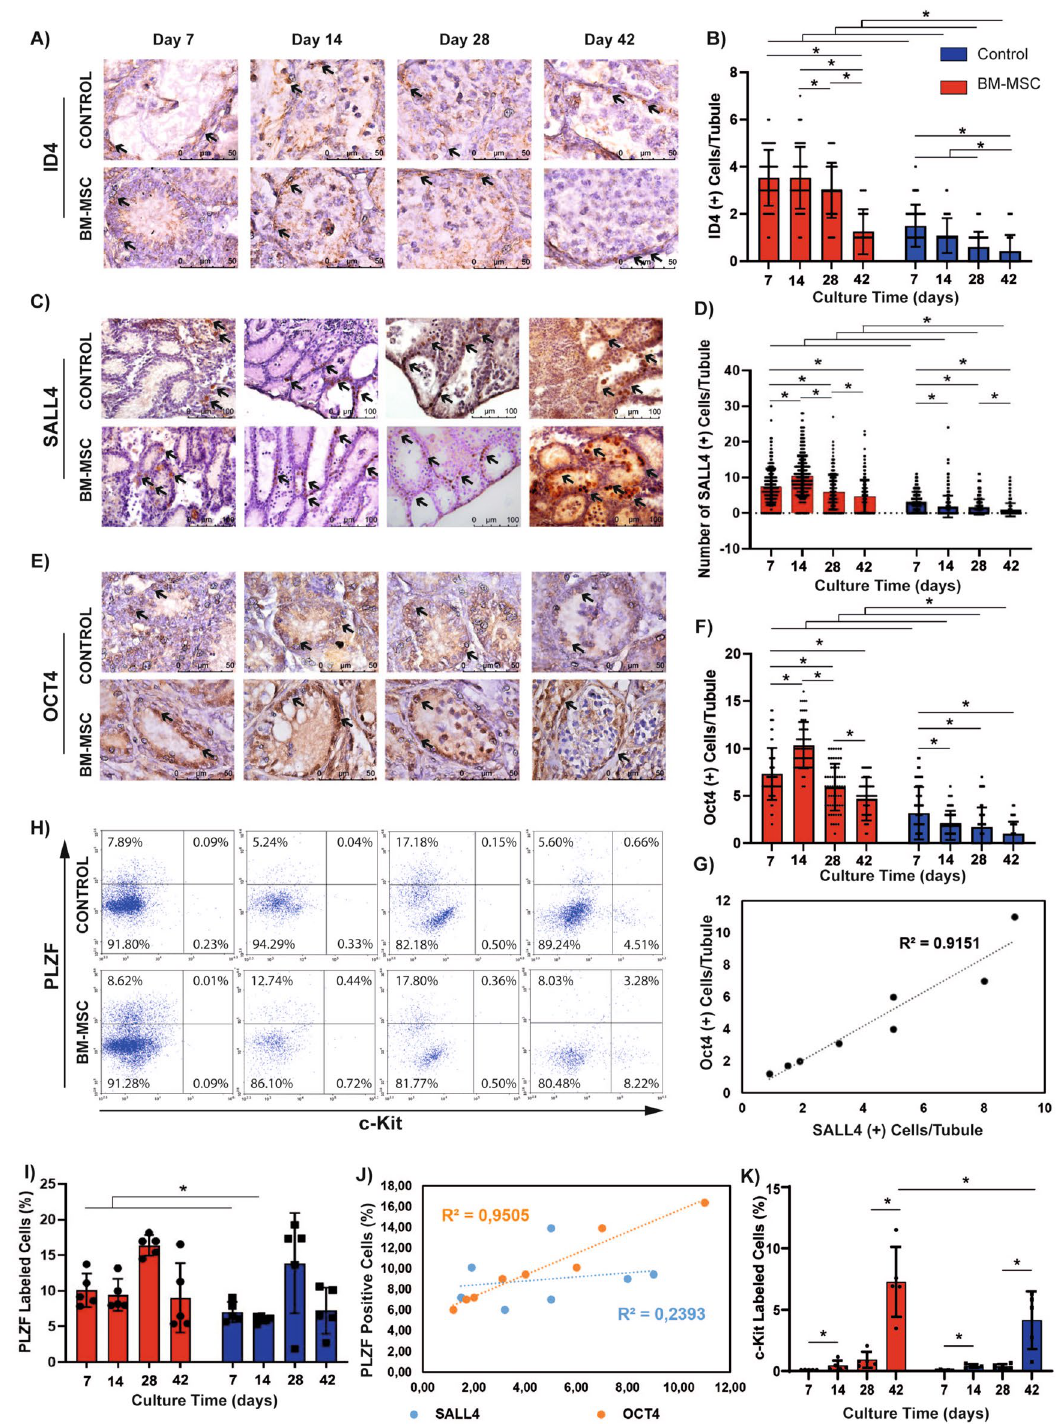
Figure 3. BM-MSCs induce the survival of ID4(+) SSCs, expansion of SALL4(+) and OCT4(+) SSPCs and c-Kit(+) differentiating GCs in vitro. Immune labeling of ( A ) ID4(+) SSCs, ( C ) SALL4 and ( E ) OCT4(+) SSPCs in neonatal mouse testes cultured for 7, 14, 28 and 42 days (ID4 and OCT4: 1000x, SALL4: 400x). The time dependent change in number of ( B ) ID4(+), ( D ) SALL4(+) and ( F ) OCT4(+) cells in BM-MSC co-culture and control group is illustrated in bar graph with standard deviation and data distribution (* p < 0.05, n = 6 testes, 300 tubules for SALL4, 60 tubules for ID4 and OCT4). ( G ) Line graph illustrates the positive correlation between OCT4 and SALL4 labelling for SSPCs in control and BM-MSC groups (R 2 = 0.9151, p < 0.05). ( H ) Flow cytometry of PLZF and c-Kit in cultured testes. ( I ) Average PLZF expression in each group was shown in bar graph with standard deviation and distribution (*p < 0.05, n = 6). ( J ) Line graph illustrates the positive correlation of SALL4 and OCT4 with PLZF for SSPCs in control and BM-MSC groups (R 2 = 0.9505 for OCT4, R 2 = 0.2393 for SALL4, p < 0.05) ( K ) The expression of c-Kit in each group was shown in bar graph with standard deviation and distribution (* p < 0.05, n =